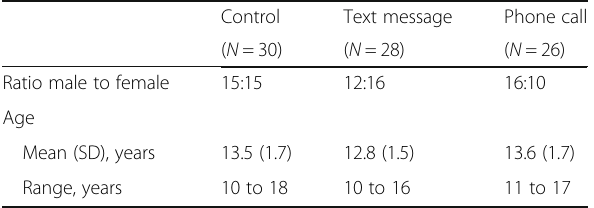
Table 1 Descriptive statistics (ratio males/females and mean age) of the groups control, text message, and phone